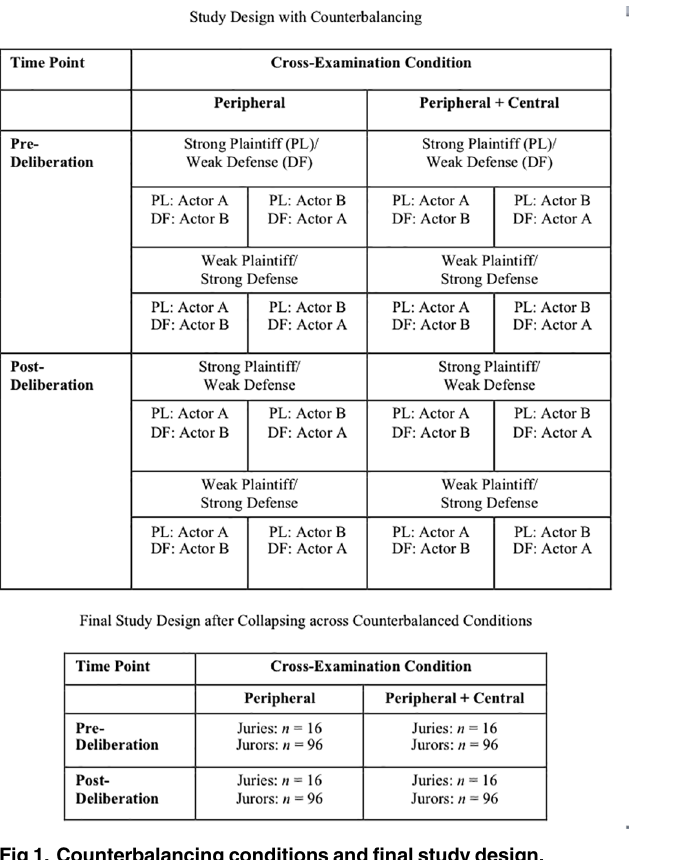
Fig 1. Counterbalancing conditions and final study